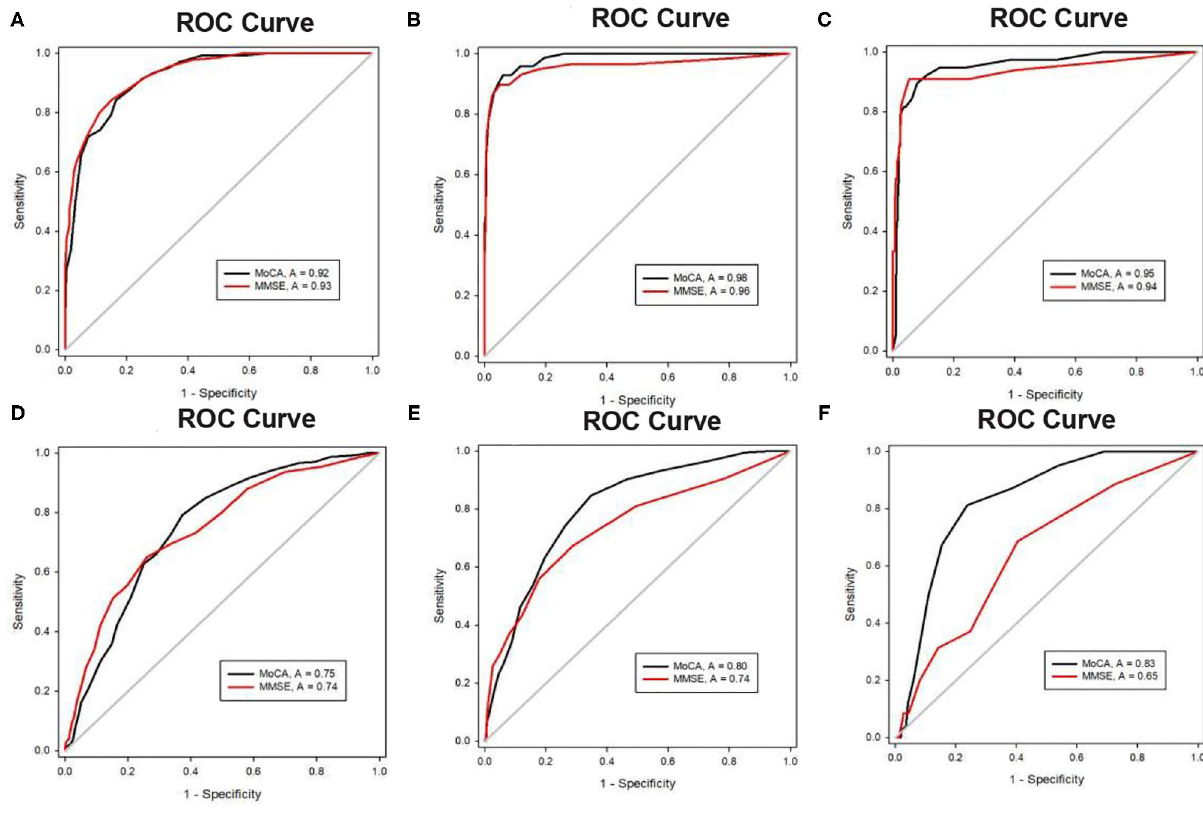
did not overlap, which indicates that the ability of the MoCA to detect MCI was significantly better than that of the